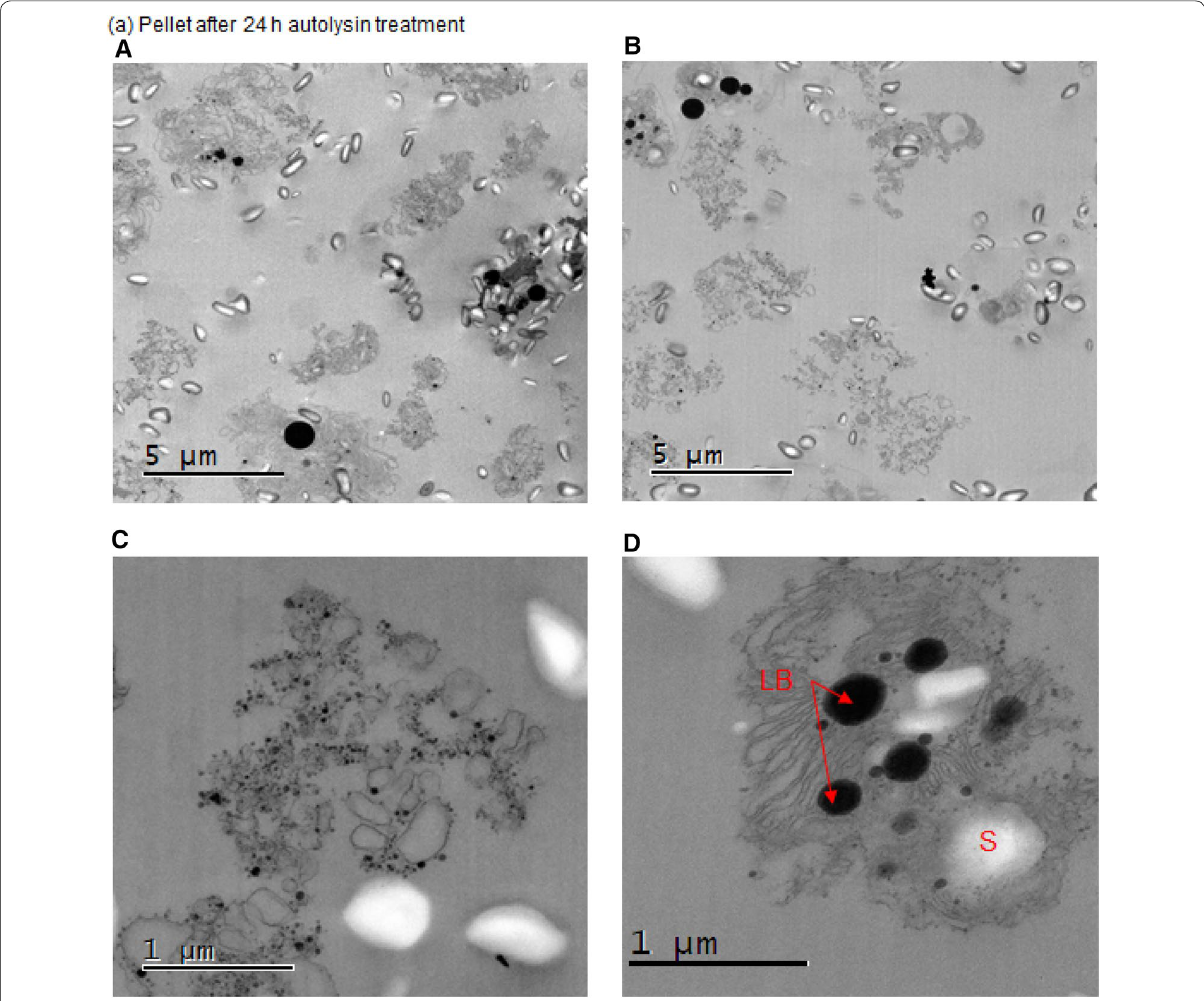
Fig. 8 TEM images of C . reinhardtii cells incubated with ( a ) autolysin‑control or ( b ) autolysin plus trypsin at 1200 and 6400 ( a , C, D and b H)) magnification. Letters indicate cellular components: S starch bodies, LB lipid bodies, T thylakoids. These images are × representative of 2 ≥